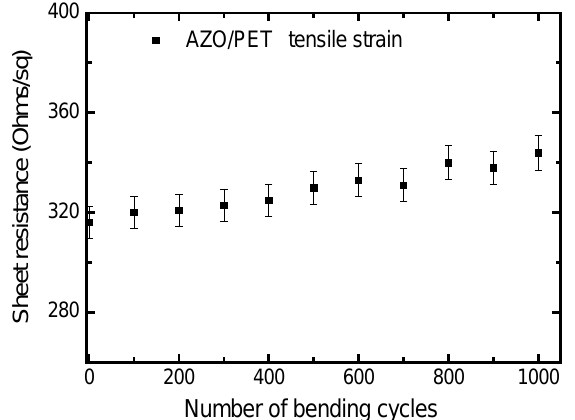
Figure 4. Sheet resistance dependence of the number of bending cycles for AZO layer on PET substrate.